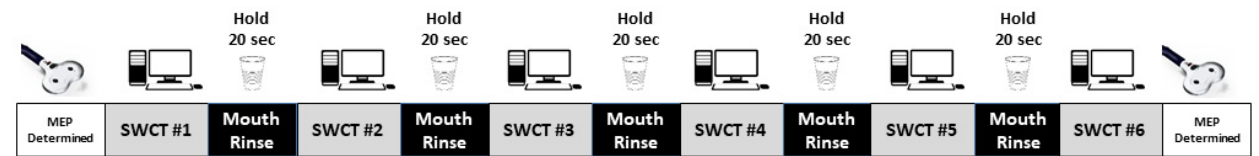
Figure 1. Experimental protocol to determine motor evoked potential (MEP) before and after repeated Stroop Color Word Test (SCWT).